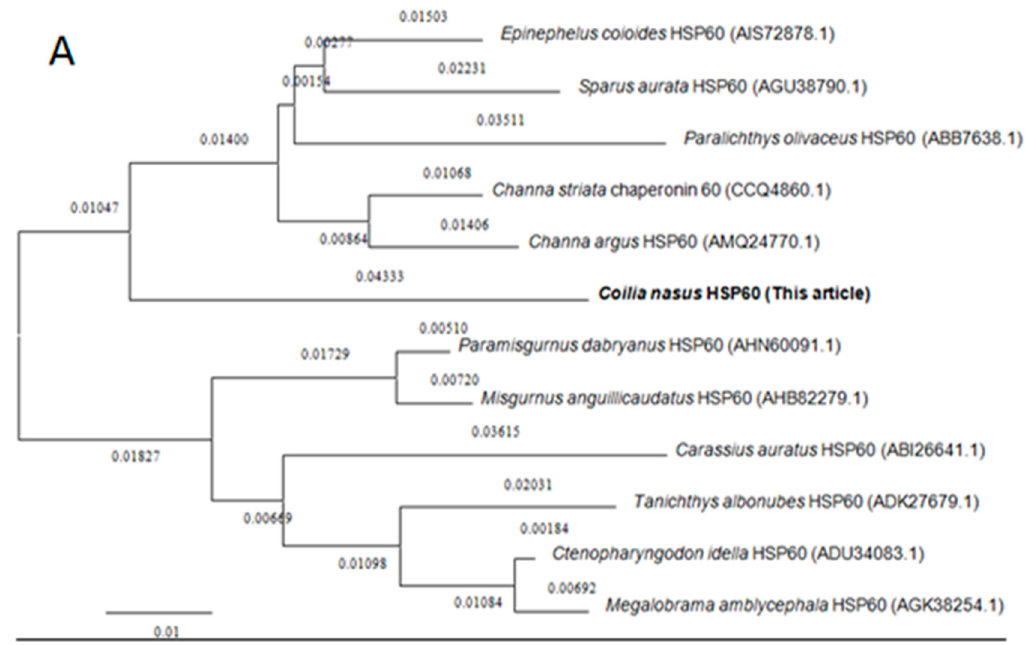
Figure 2. Cont Figure 2. Cont.